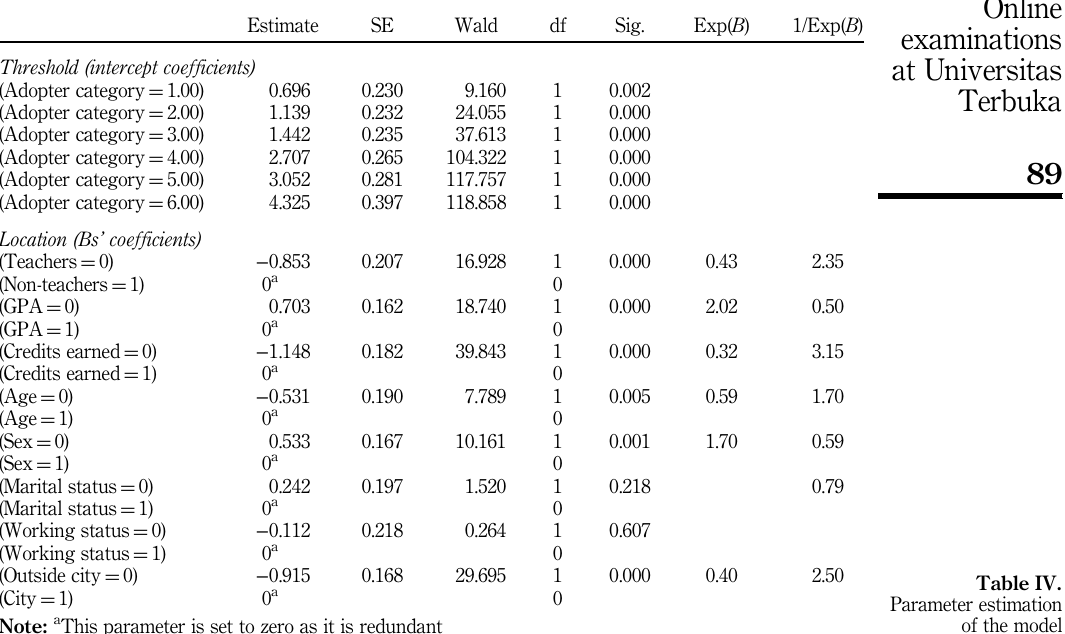
Table IV. Parameter